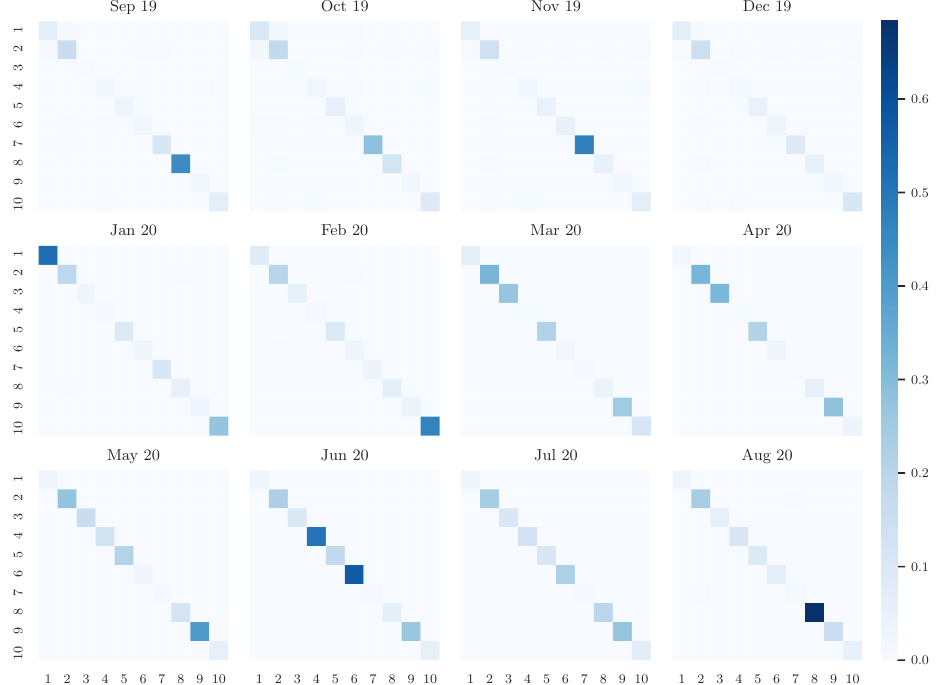
Figure 9. Colored heatmap of affinity tensor R , trained on the New York Times news article data represented as input tensor using multiplicative update rules.